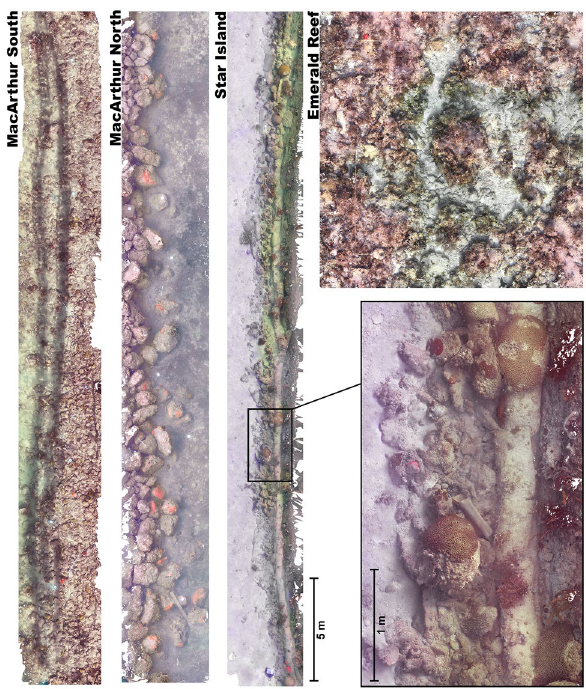
Figure 4. Photomosaics of each benthic study site including three elongated urban sites, as well as the natural offshore Emerald Reef. Inlay shows zoomed-in section of the Star Island mosaic. Scale bars are 5 m and 1 m in the main and zoomed-in views,